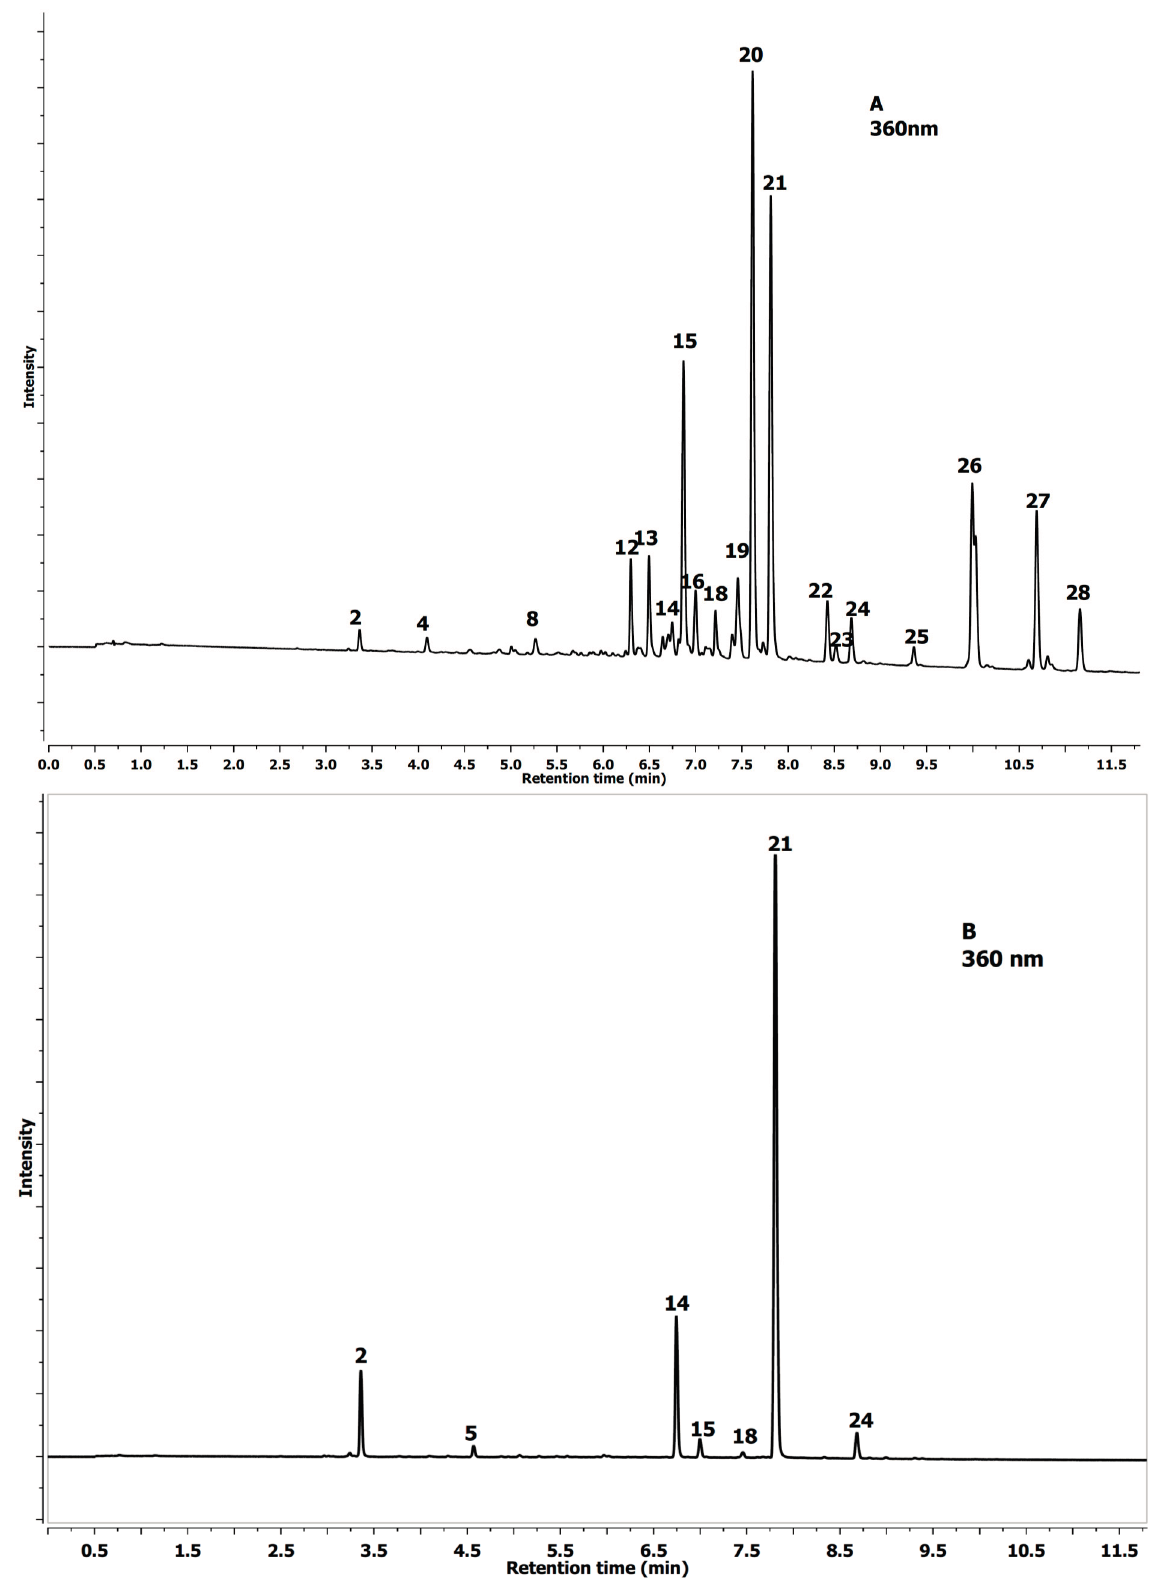
Figure 1. UPLC chromatogram profile of Aesculus glabra ( A ) and Aesculus parviflora Walt.; ( B ) chestnut leaf extracts at 360 nm (phenolic acid and quercetin derivative). See Table 1 for the peak